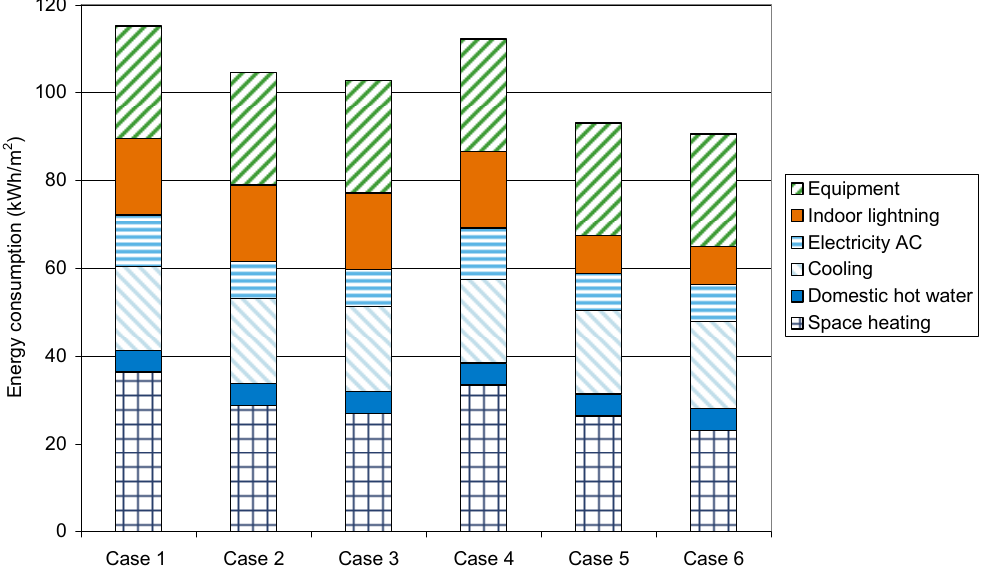
Figure 1. Yearly energy consumption in different cases. Electricity AC represents for electricity for air conditioning